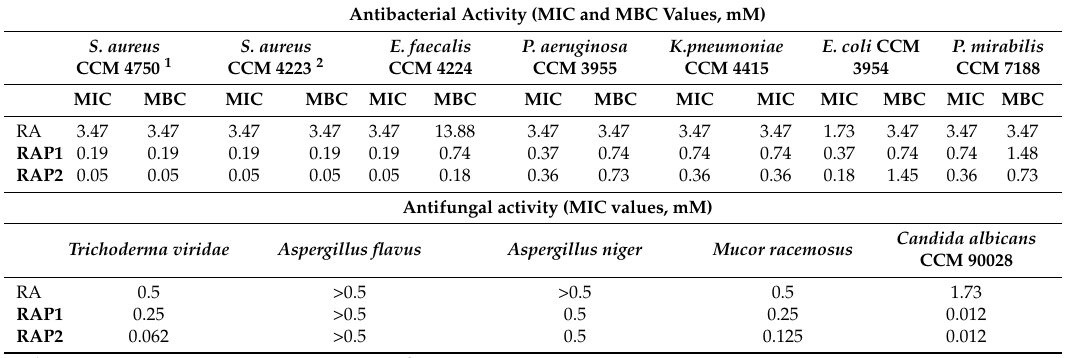
Table 2. Antibacterial and antifungal activity of RA and its phosphonium salts RAP1 and RAP2.